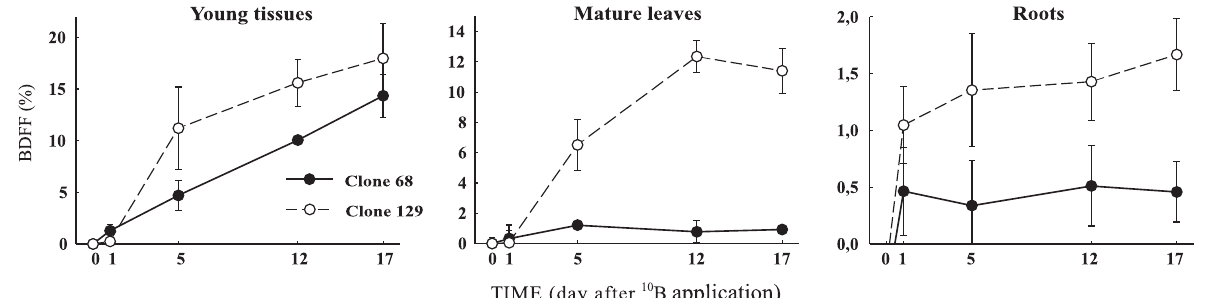
Figure 6. Percentage of B derived from foliar fertilization (BDFF) in the young tissues, mature leaves and roots over the course of time after 10 B application to a mature leaf of eucalypt